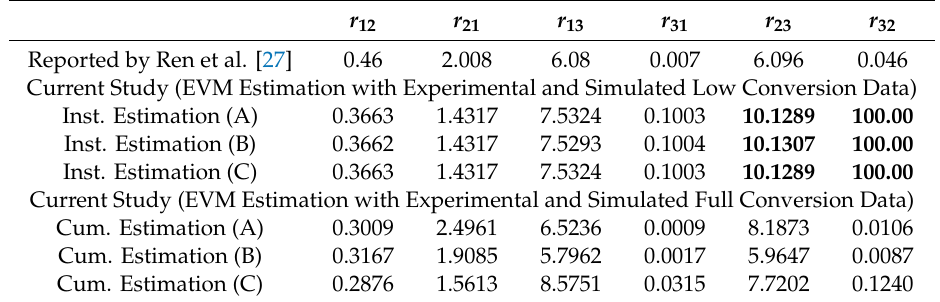
Table 3. Reactivity ratio estimates for terpolymerization of BA / BMA / lim with supplemental data (experimental data from [27] and simulated data from current